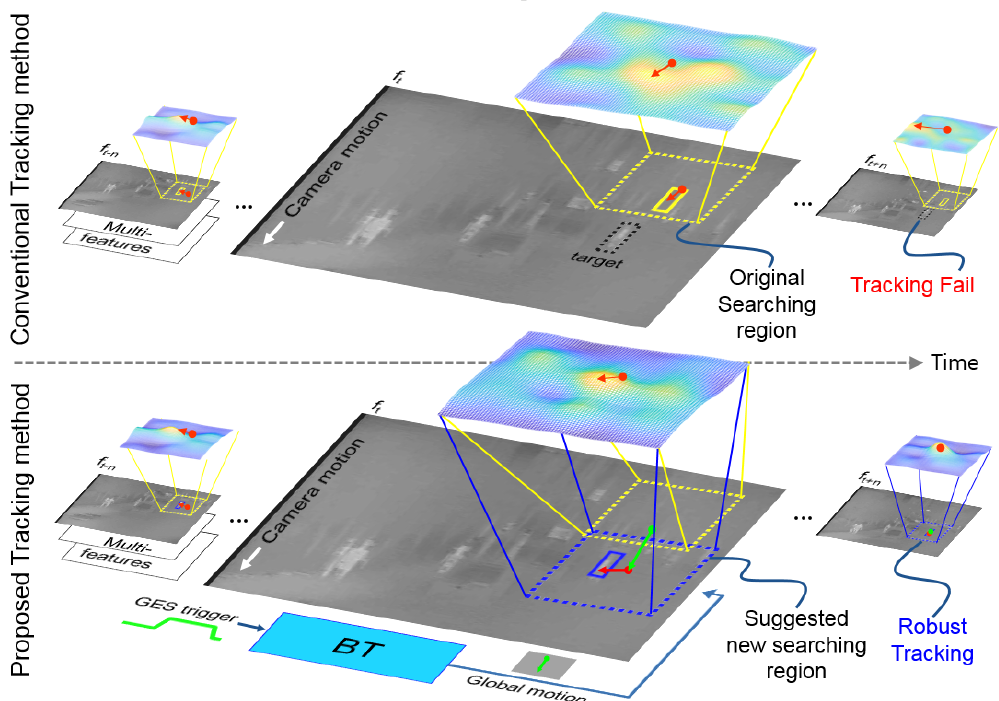
Figure 5. Comparison of the tracking method that does not estimate global camera motion (upper) and the tracker that uses the proposed global camera motion estimation method. The conventional method fails in the event of significant camera motion since the target disappears from the search range. The proposed method estimates the global camera motion and corrects the position of the tracker before localization, which results in successful